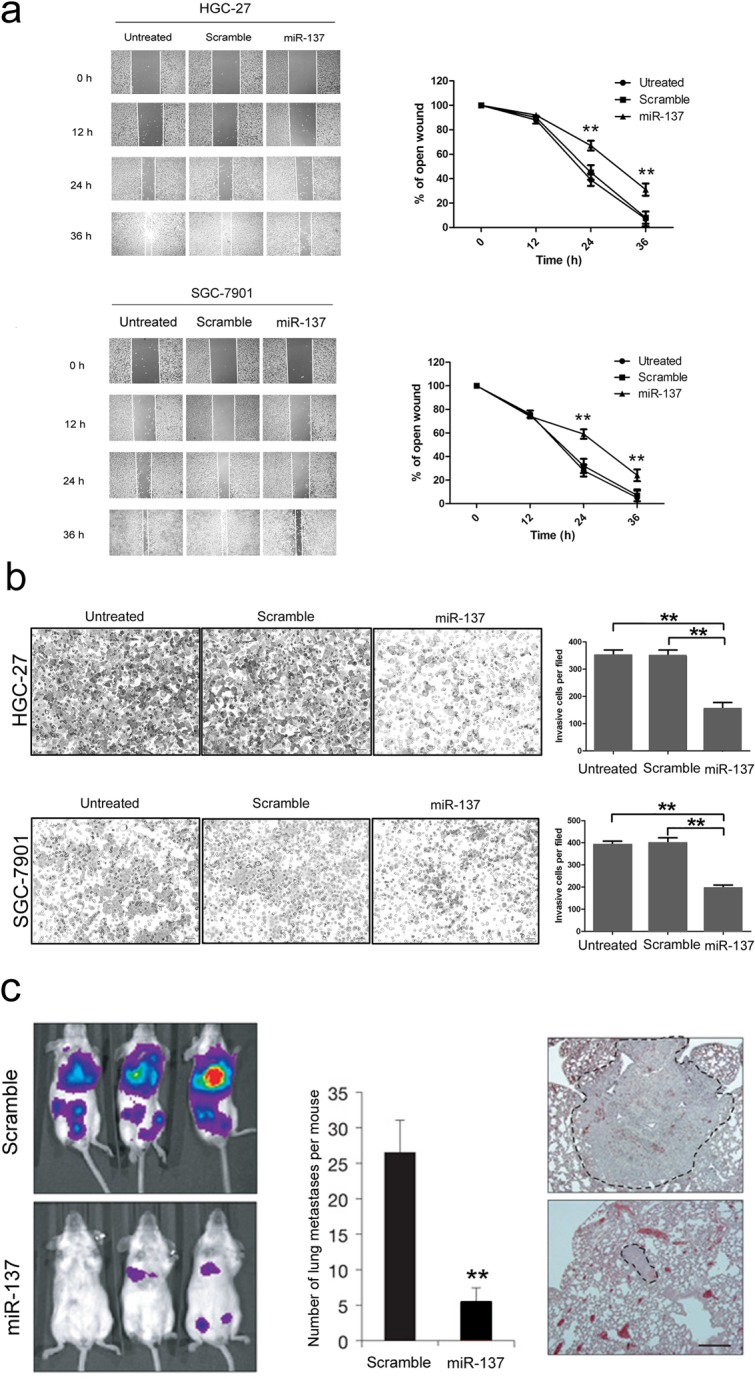
Overexpression of miR-137 inhibits gastric cancer cell migration and invasion.
A. SGC-7901 and HGC-27 cells were not transfected or transfected with miR-137 mimics or scramble for 24 hours, and wounds were made. The relative ratio of wound closure per field is shown. As a result, cells transfected with miR-137 showed a significantly higher migrate speed compared to the control. B. HGC-27 and SGC-7901 cells were not transfected or transfected with miR-137 mimics or scramble for 24 hours, and transwell invasion assay was performed. The relative ratio of invasive cells per field is shown. Magnification for identification of migration is ×400 and invasion is ×40. This result demonstrated that the migration ability of lung cancer cells can be inhibited by miR-137 overexpression. C. Bioluminescentimaging (left) and the number of lung metastasis per mice (middle) showed that the miR-137 can suppress metastasis in vivo. The HE staining showed that the metastasis in mice lung (right).